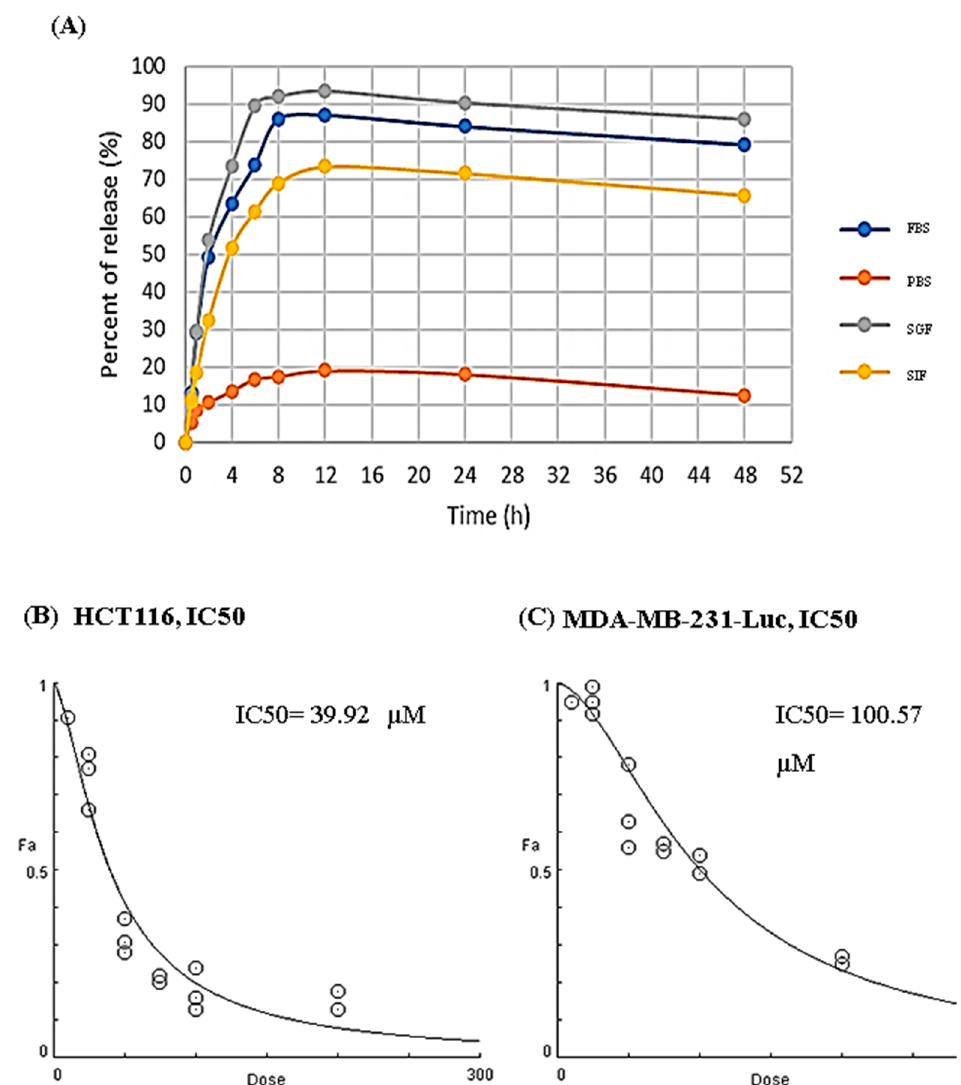
Figure 2. In-vitro release kinetics and IC50 values of costunolide (COS). ( A ) Release kinetics of COS in fetal bovine serum (FBS), phosphate-buffered saline (PBS), simulated gastric fluid (SGF), and simulated intestinal fluid (SIF) using spectrophotometric analysis and standards calibration curve. under different biological conditions. ( B ) IC50 values of COS against HCT116. ( C ) IC50 values of COS against MDA-MB-231-Luc. Values are presented as mean ± SD.